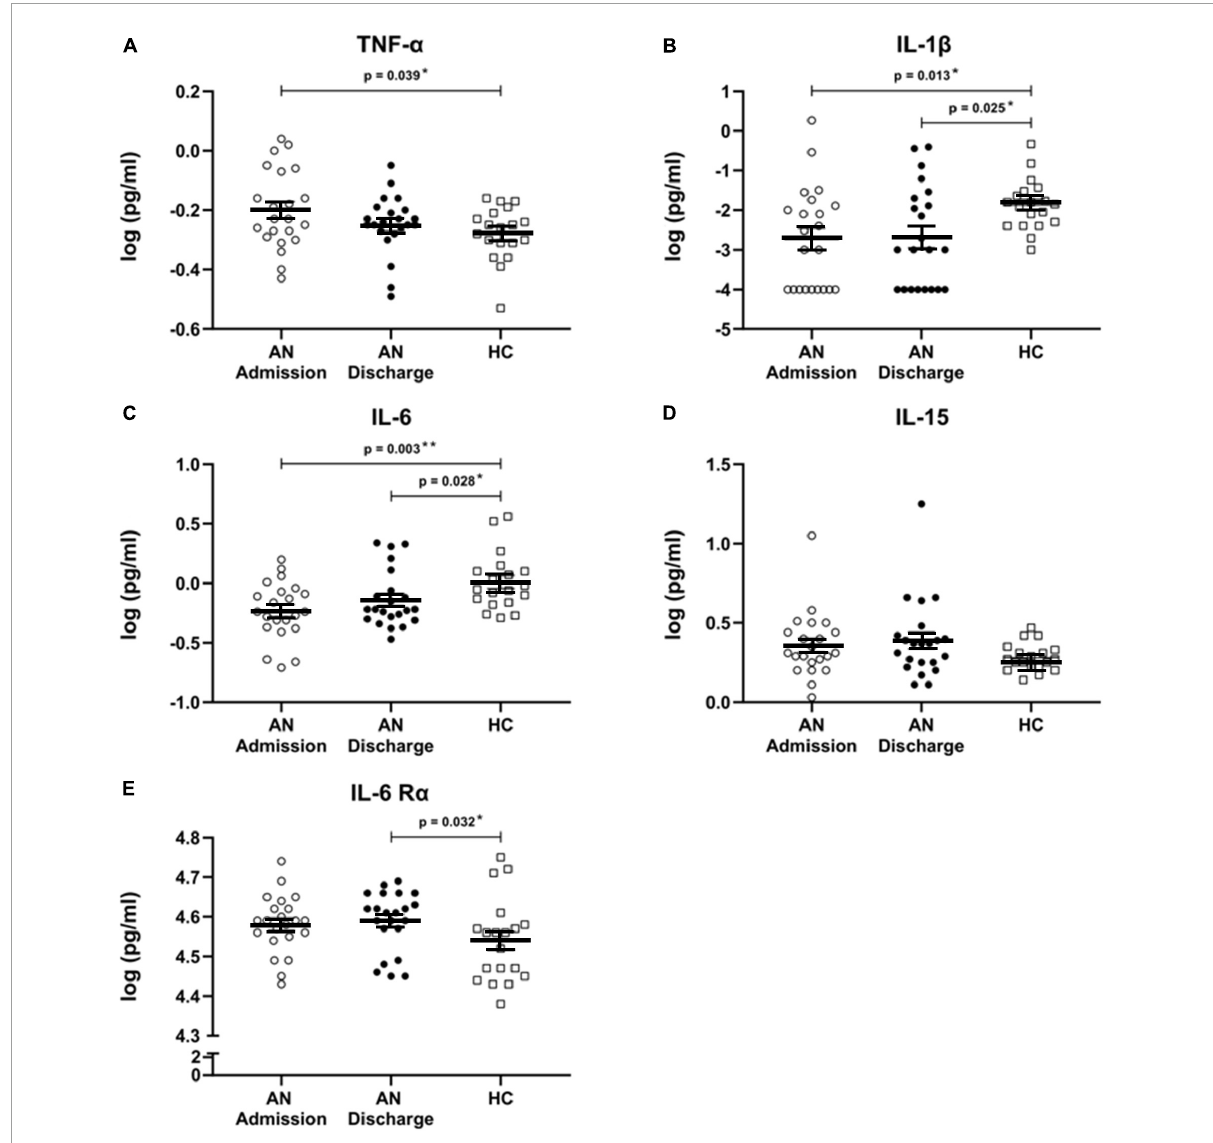
FIGURE1 (A–E) Cytokines and cytokine receptor. Scatterplots showing serum cytokine levels with mean and standard error in patients with anorexia nervosa (AN) at admission to hospital, at discharge and in healthy controls. All cytokine data were log transformed. Independent t -tests were used to compare TNF- α at admission and discharge with HC and for IL-6 and IL-6 R α at admission versus HC. For all other cytokines, Mann–Whitney U tests were used due to a non-normal data distribution. A paired sample t -test was used to compare AN at admission and at discharge for TNF- α . Wilcoxon signed rank tests were calculated for all other cytokines. All comparisons remained significant when using a false discovery rate of q < 0.1 to correct for multiple